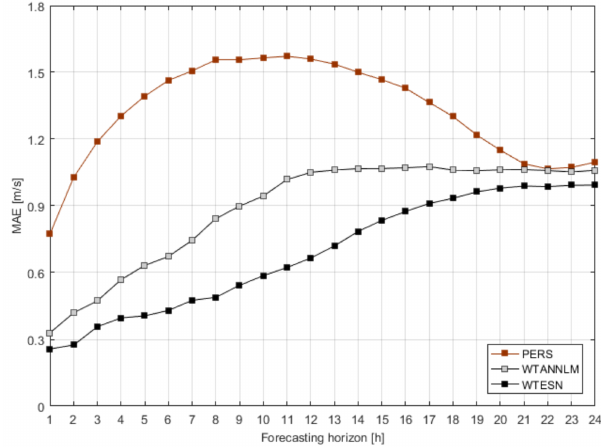
Figure 15. MAE of wind speed forecasts for Macau.